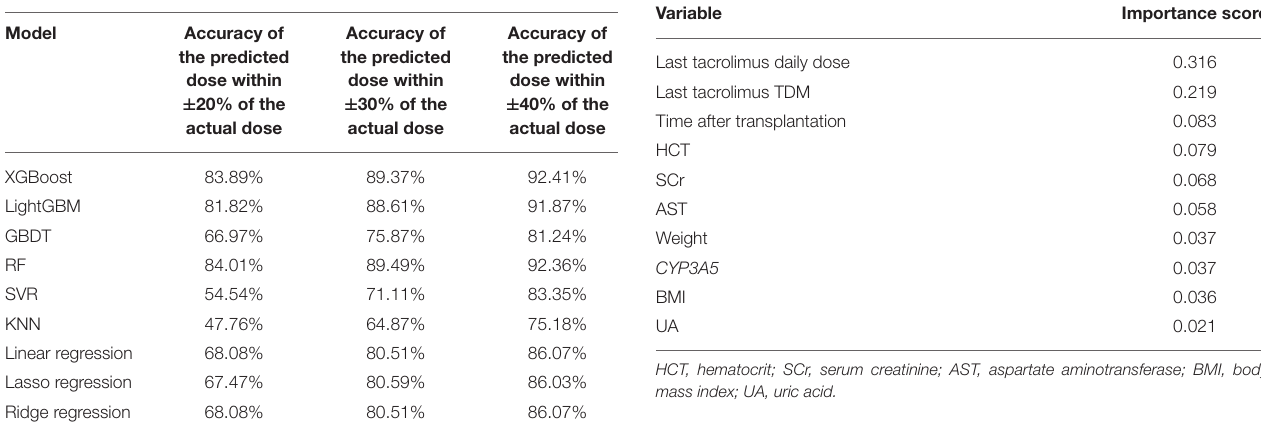
TABLE 4 | The prediction accuracy of the predicted value in different confidence intervals.